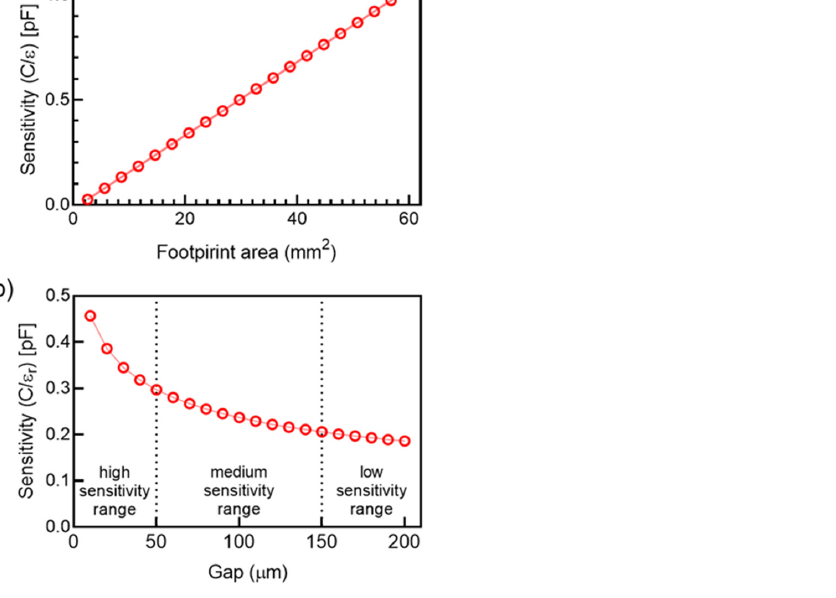
Figure 12. Effects of geometrical parameters of the IDEA on the sensitivity of the transducer: ( a ) effect of the footprint area of the electrodes and ( b ) effect of the gap between electrode fingers.